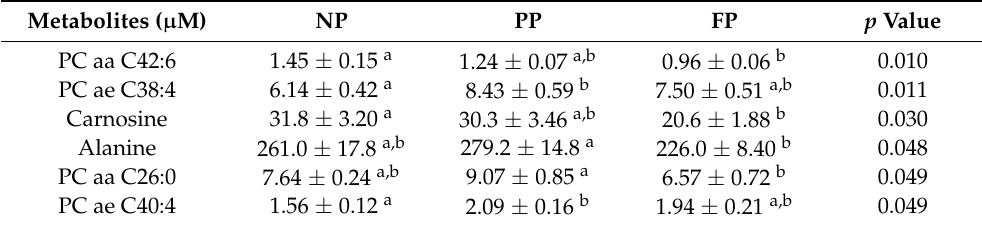
Table 3. Mean concentration of significant metabolites ± standard error of the mean for offspring at 30 days of age submitted to different prenatal nutrition approaches (NP, PP and FP) with their respective p values.